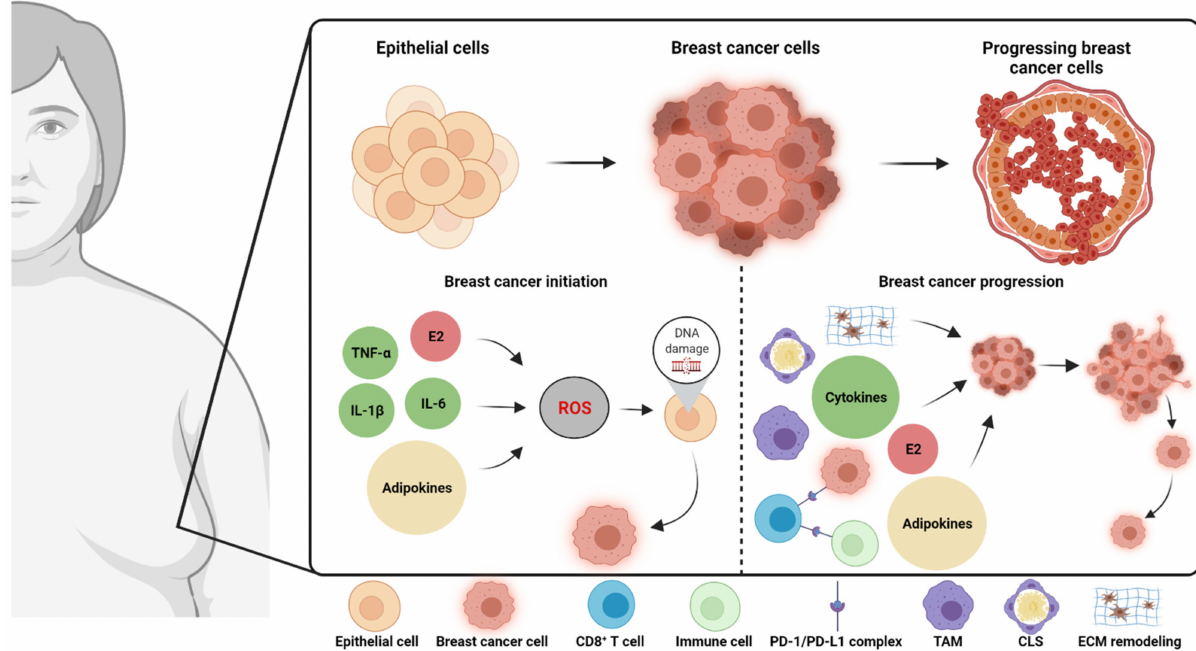
Figure 1. Local obesity-associated biomarkers involved in breast cancer initiation (left panel) and breast cancer pro- gression (growth, proliferation, invasion, migration, etc., right panel). Left panel: In the obese breast, the secretion of pro-inflammatory cytokines is increased. TNF- α , IL-1 β , and IL-6 are associated with an increased production of ROS, which could induce DNA damage in the mammary epithelial cell, and, thereby, the initiation of breast cancer. Studies on obesity-associated adipokines (leptin, resistin, and fatty acid-binding protein 4) have shown similar mechanisms. In addition, the level of 17 β -estradiol is increased, which induces DNA damage, mainly through ROS production. Right panel: Altered levels of pro-inflammatory cytokines, various adipokines, and 17 β -estradiol may lead to tumor progression in the obese breast. Immune cells (macrophages and CD8 + T cells) are associated with breast cancer progression, too. Remodeling of the extracellular matrix (involving matrix metalloproteinases and collagens) influences tumor progression, for example, through the promotion of invasion and metastasis. Abbreviations: E2 = 17 β -estradiol; IL = interleukin; TNF- α = tumor necrosis factor alpha; TAM = tumor-associated macrophages; ECM = extracellular matrix; CLS = crown-like structures; ROS = reactive oxygen species; PD-L1 = programmed death-ligand 1; PD-1 = programmed cell death 1. Created with BioRender.com by the